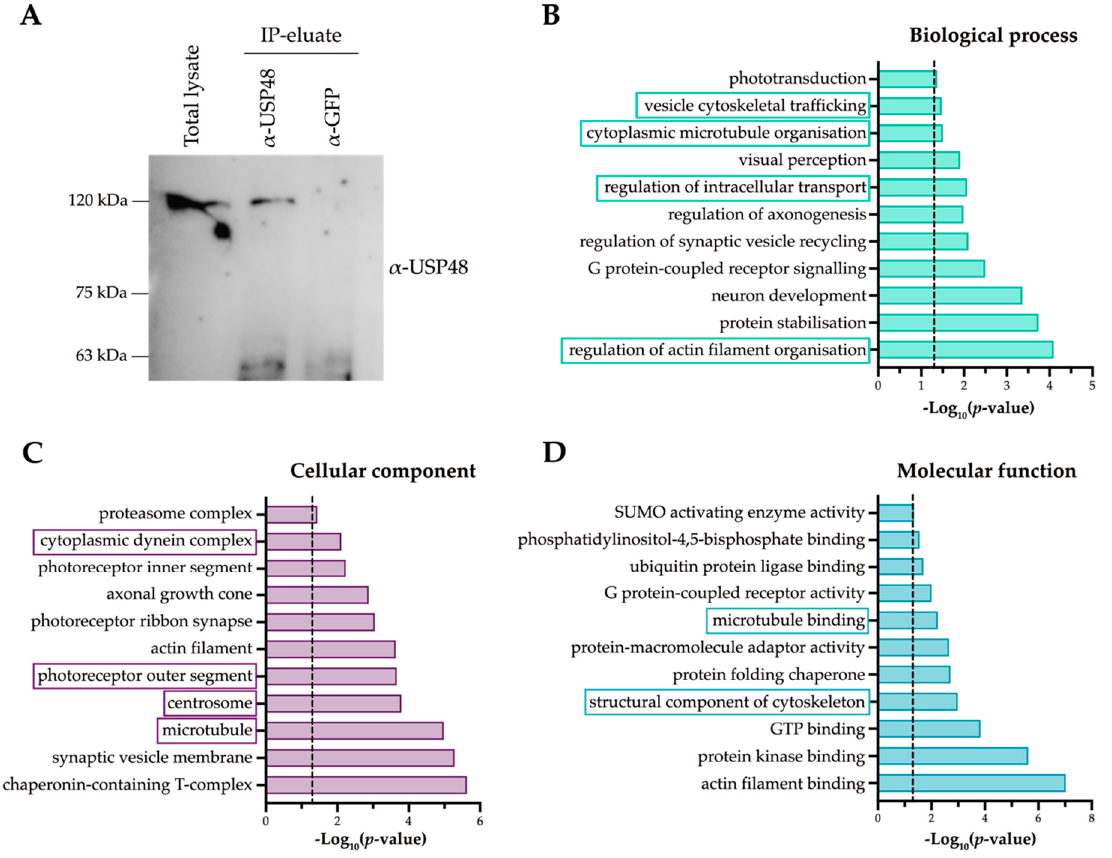
Figure 5. USP48 interacts with proteins involved in ciliary morphogenesis, ciliary trafficking, and photoreceptor-specific functions. ( A ) Endogenous retinal USP48 (approx. 120 kDa) from mouse retinas was successfully and specifically immunoprecipitated in non-denaturing conditions. Anti-GFP was used as a negative control. ( B – D ) Graphical representation of the − Log 10 ( p -value) of the GO terms of USP48 interactors after proteomics analysis, highlighting specific terms related to ciliary function. Discontinuous lines represent the cut-off of p -value ≤ 0.05 in each graphic.